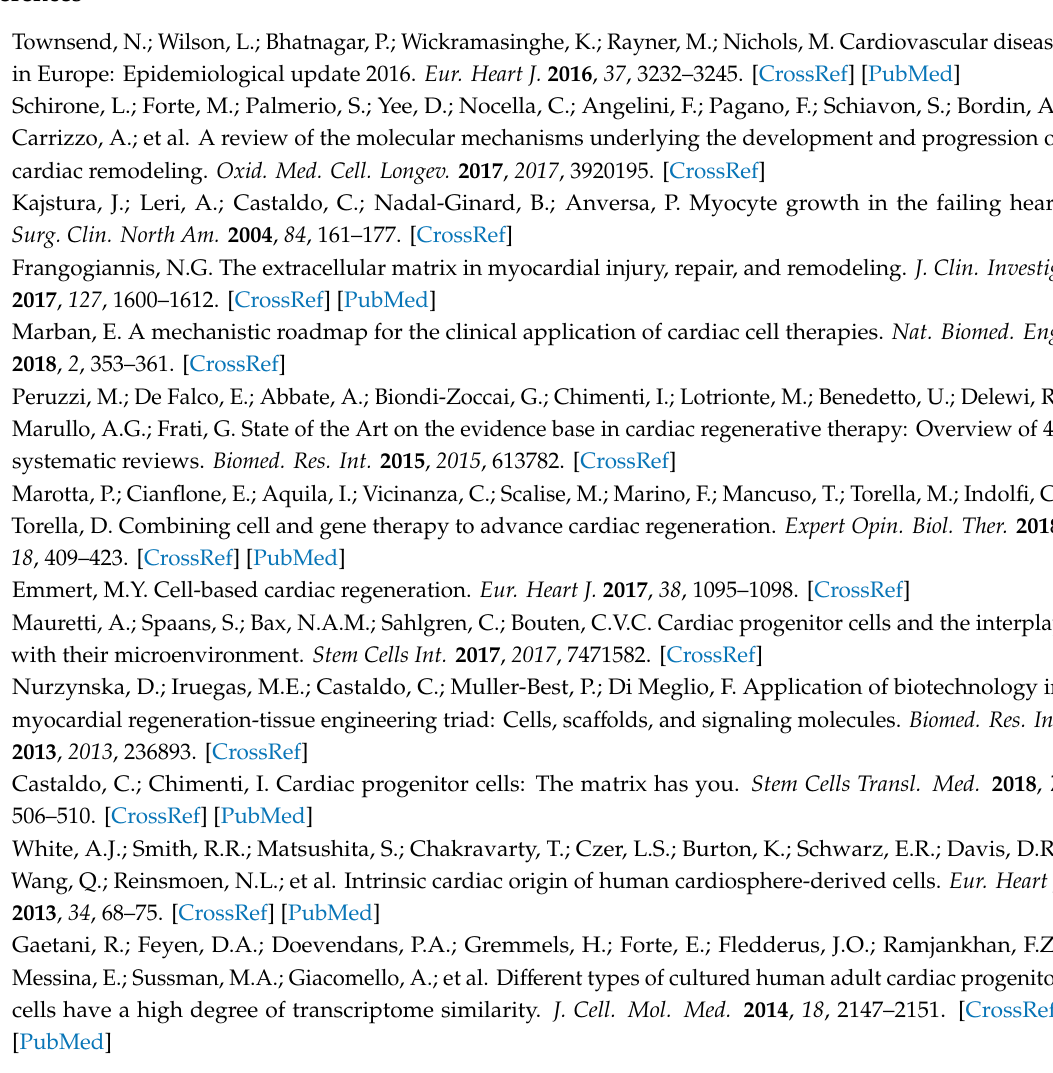
Figure S1: Gene expression levels of adhesion and matrix